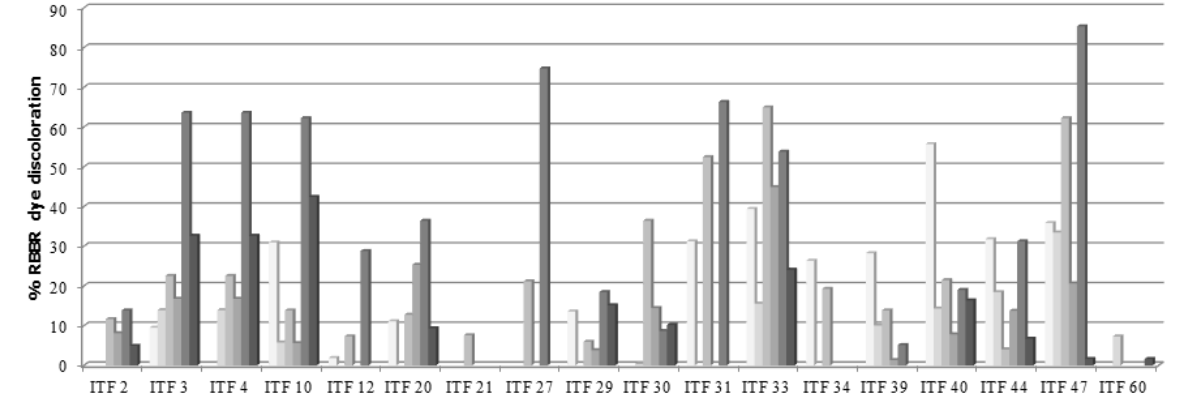
Figure 1. Percentage of discoloration (500 mg L -1 and 1000 mg L -1 ) of RBBR dye by fungal